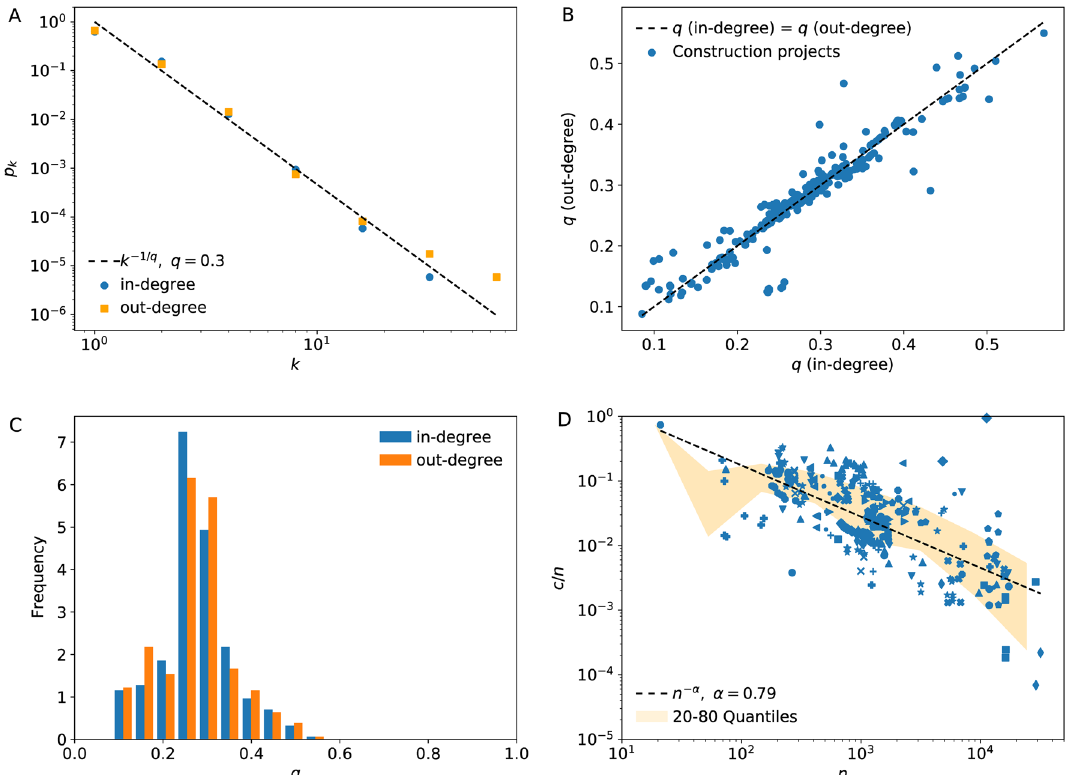
Figure 4. Empirical data analysed. ( A ) Distribution of the number of predecessors (in-degree) and successors (out-degree) across activities of a typical construction project. The dashed line highlights a power law fitting the data. ( B ) The exponents q obtained from the fit to the distribution of the number of predecessors q(in-degree) and successors q(out-degree) . Each point represents a project schedule. The dashed line is the equality line. ( C ) The distribution of estimated duplication rate q across projects. ( D ) The fraction of activities in the critical path as a function of the number of activities. Different symbols represent a project schedule at different stages of completion. The solid background represents the [20,80]% confidence